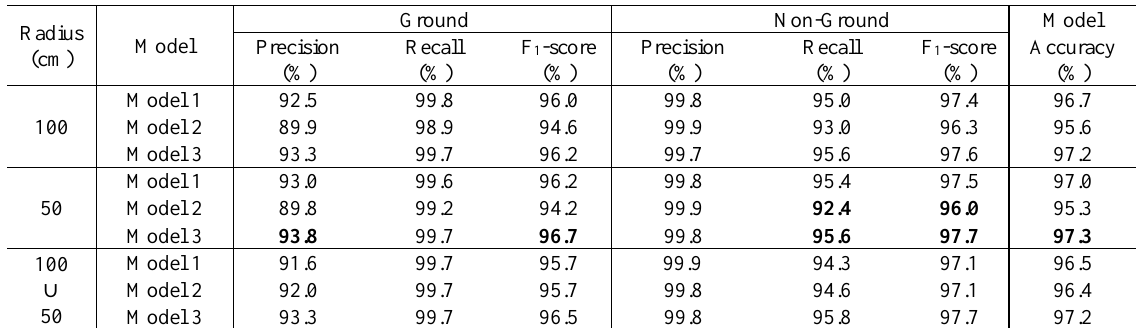
Table 3. Results show the performance of the proposed algorithm for the AHN test